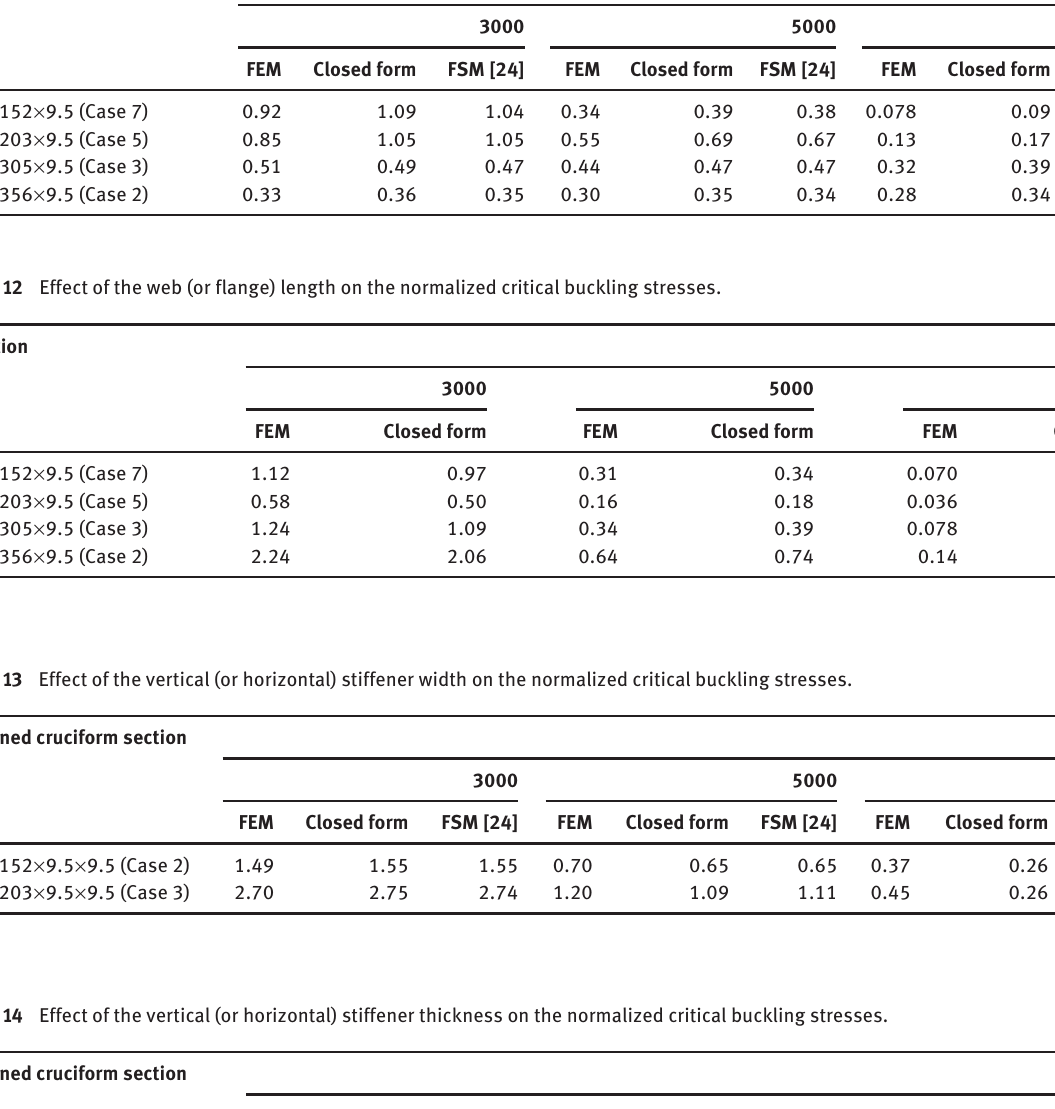
Table 11 Effect of the web (or flange) length on the normalized critical buckling stresses. Unstiffened cruciform section